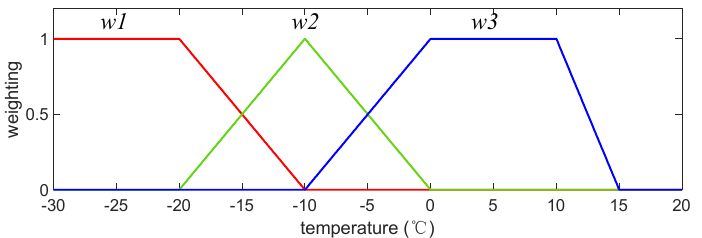
Figure 9. Weightings of the output variables of FLC in the three different temperature regions.